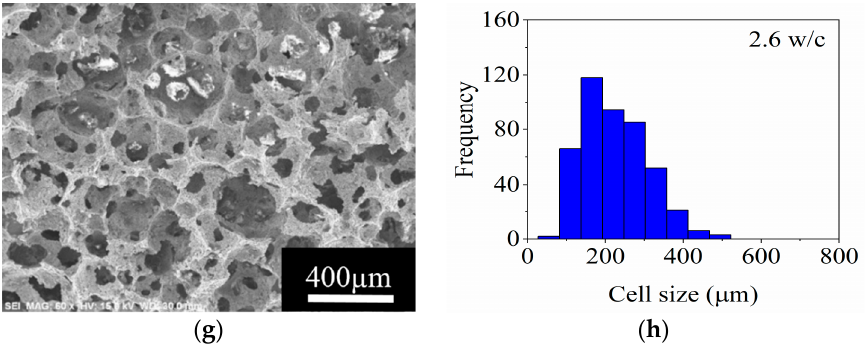
Figure 14. SEM micrographs and frequency histograms of cell size for the ceramic foams obtained after drying at: ( a ) and ( b ), 40 °C; ( c ) and ( d ), 50 °C; ( e ) and ( f ), 60 °C; and ( g ) and ( h ), 70 °C, respec- tively.